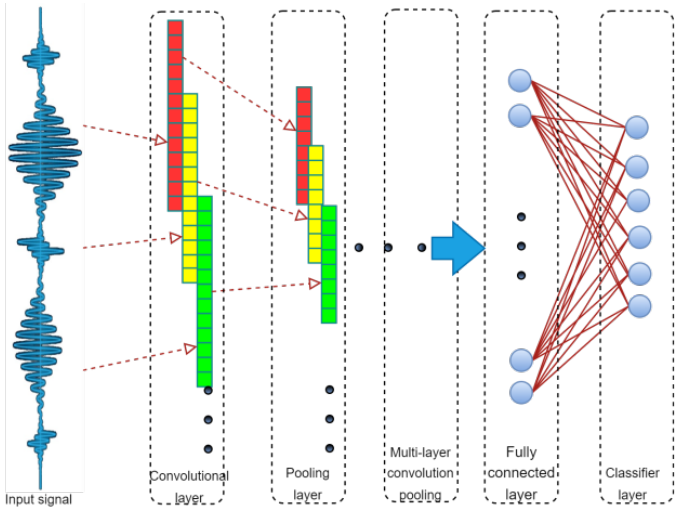
Figure 1. Schematic diagram of a one-dimensional convolutional neural network. 138